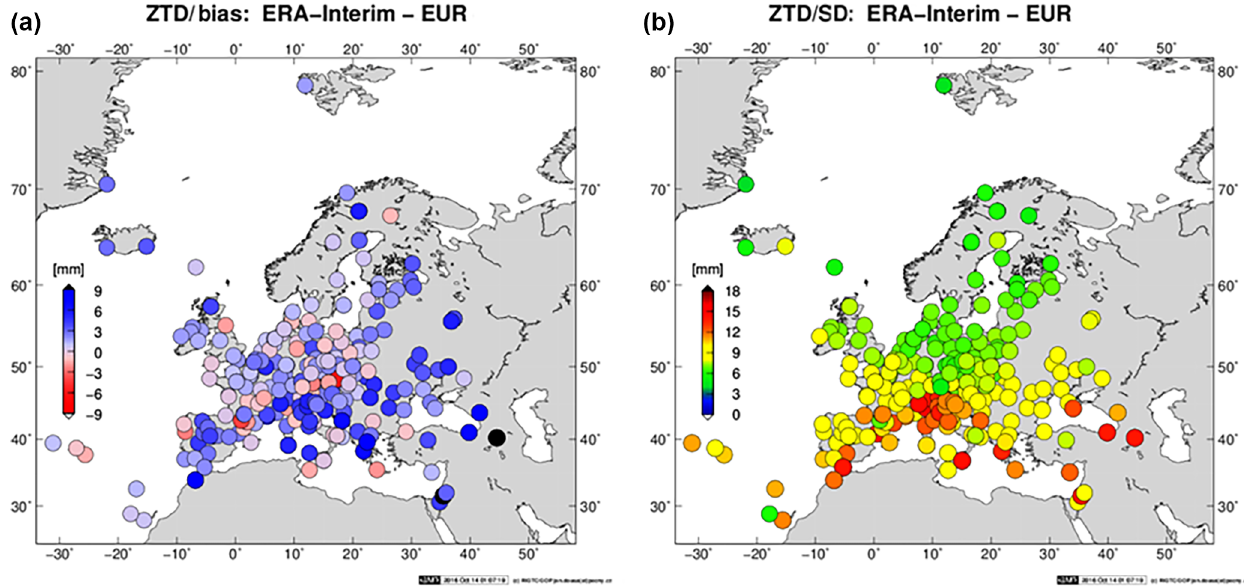
Figure 14. Geographical distribution of ZTD biases (a) and standard deviations (b) for EPN-Repro2 compared to ERA-Interim (ERA-Interim minus